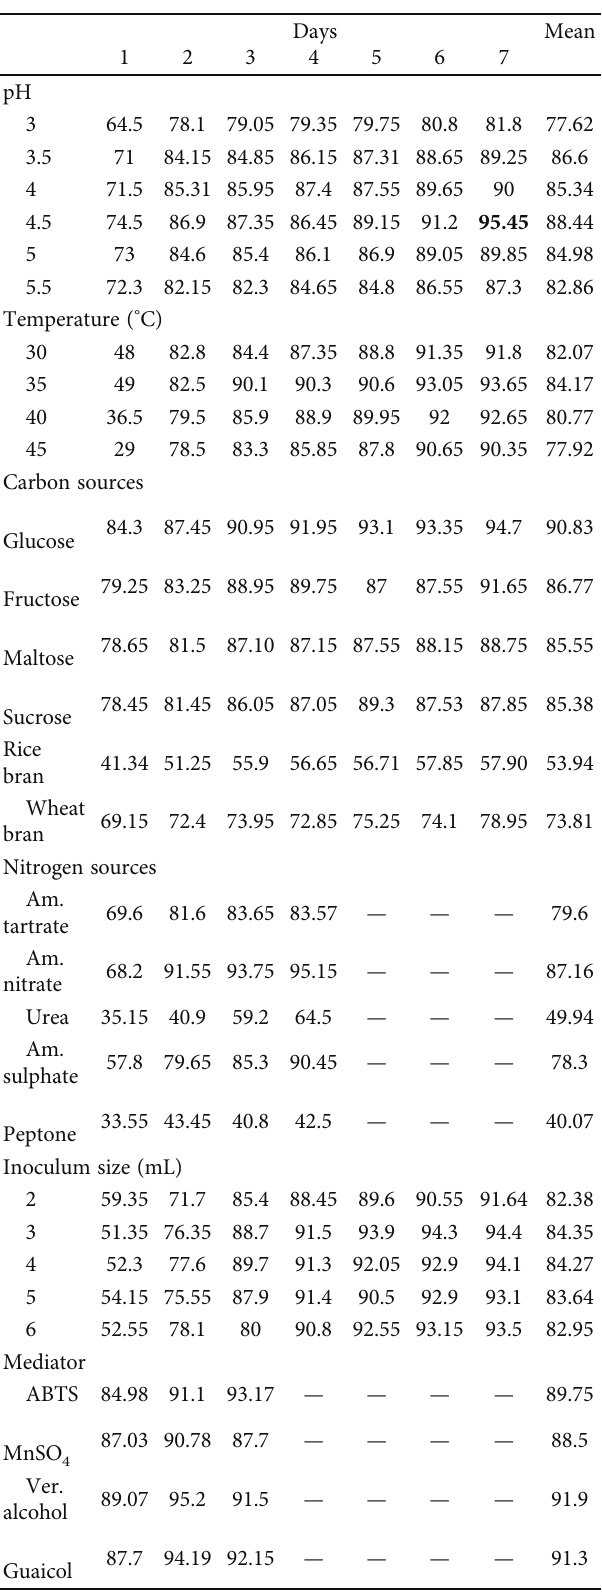
Table 2: Removal (%) of Drimaren Turquoise CL-B at di ff erent pH, temperature, carbon sources, nitrogen sources, inoculum size, and mediator e ff